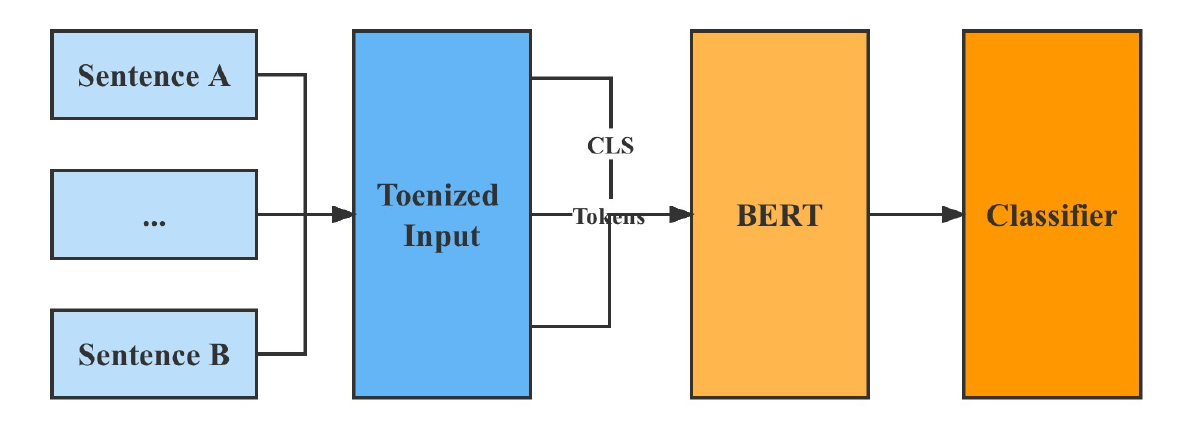
Figure 6. Training process of the BERT network.